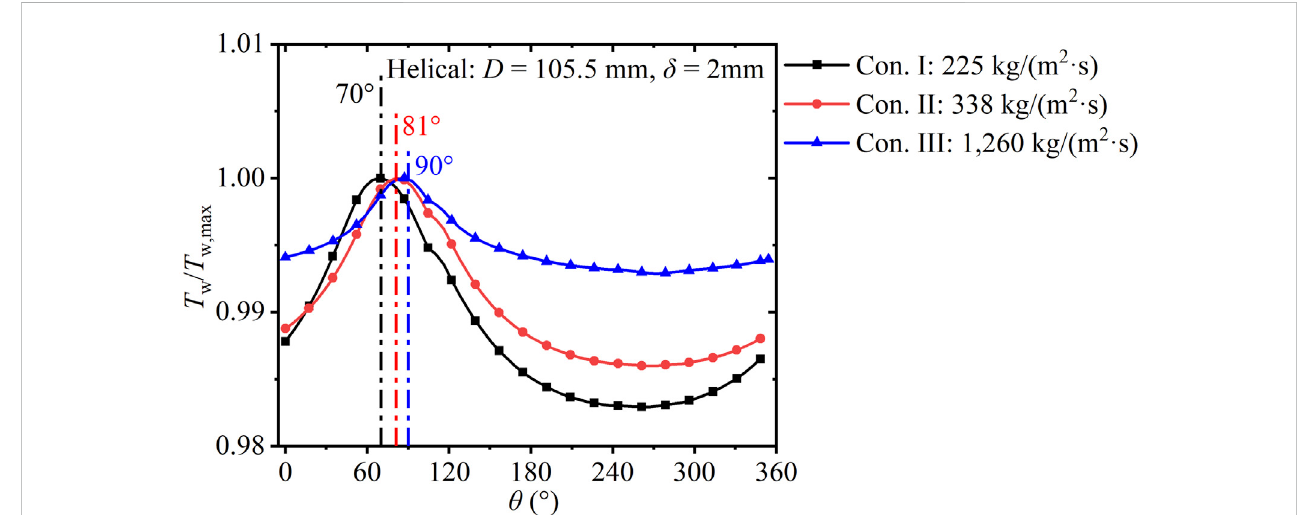
Development of circumferential T w / T w,max in helical tubes versus θ under various conditions ( D = 105.5 mm, δ = 2 mm).